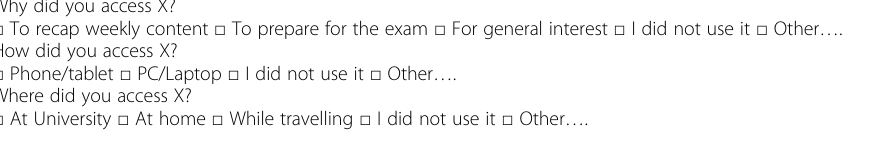
Why did you access X? □ To recap weekly content □ To prepare for the exam □ For general interest □ I did not use it □ Other …